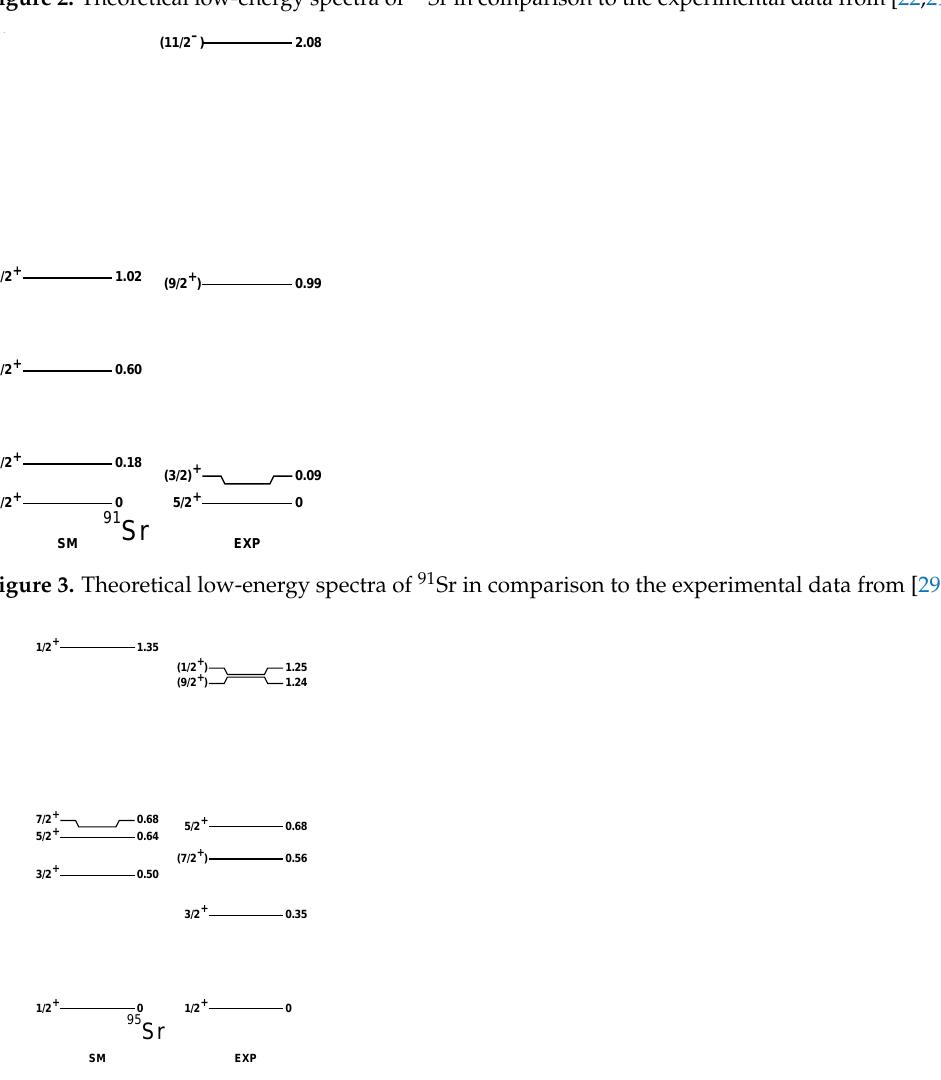
Figure 4. Theoretical low-energy spectra of 95 Sr in comparison to the experimental data from [22,29]. To investigate further the single-particle structures in Sr isotopes, the spectroscopic factors were computed in 89,93,95 Sr, to be compared with the data obtained in [21,22,30]. They are summarized in Table 1. For 95 Sr, two sets of data are listed (from